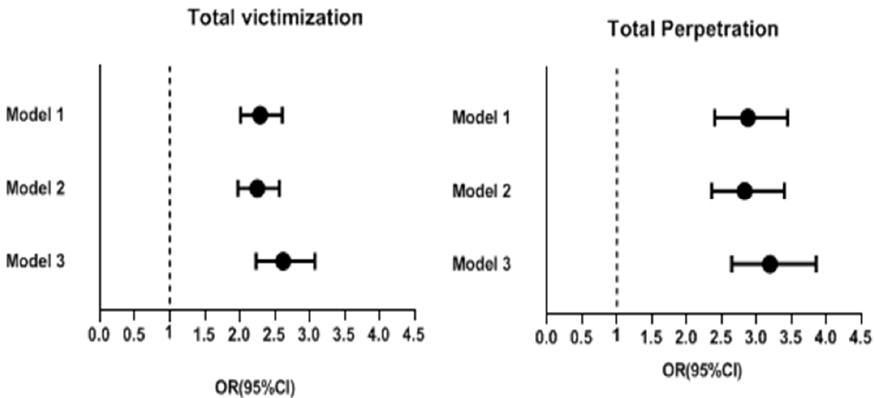
Figure 1. Crude ORs and adjusted odds ratios for the incidence of overall bullying victimization and perpetration before and during the pandemic (error bars represent 95% confidence intervals).